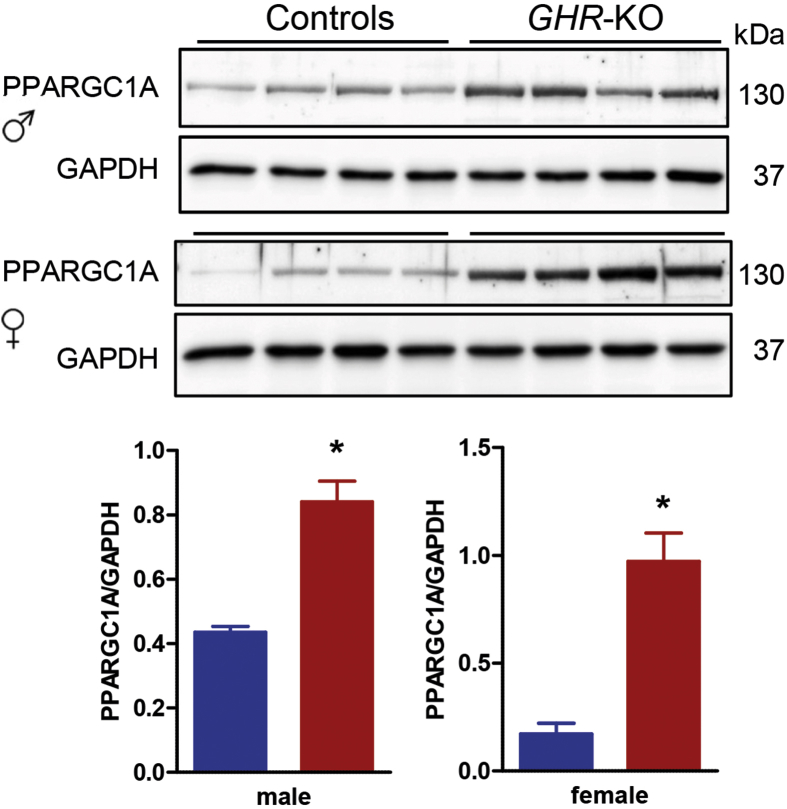
Western blot analysis of PPARGC1A in liver extracts from GHR-KO and control pigs. GAPDH was used as reference protein. Corresponding densitometrical analysis illustrating a significantly increased expression of PPARGC1A in liver of GHR-KO pigs compared to controls. Data were analyzed by Mann Whitney U-test and are presented as means ± SEM (n = 4/group), ∗p < 0.05.